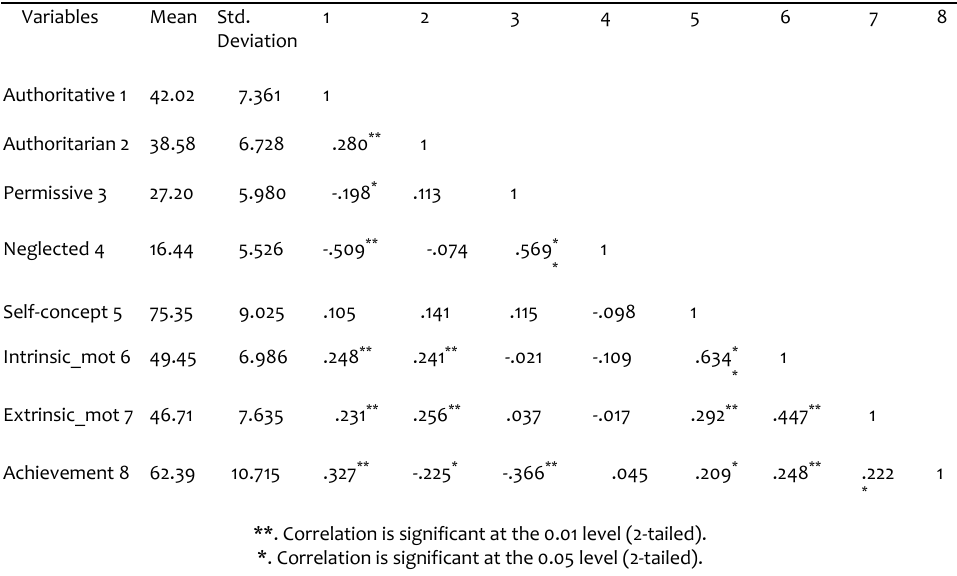
Table 3: The Mean, Std. Deviation and interrelationship among predictor variables and academic